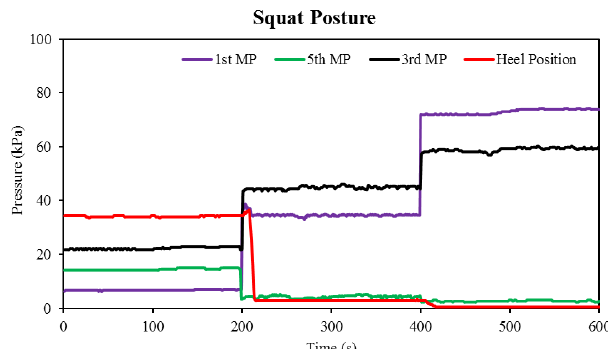
Figure 8. Pressure changes of Flexi force sensors against time during the squat posture.